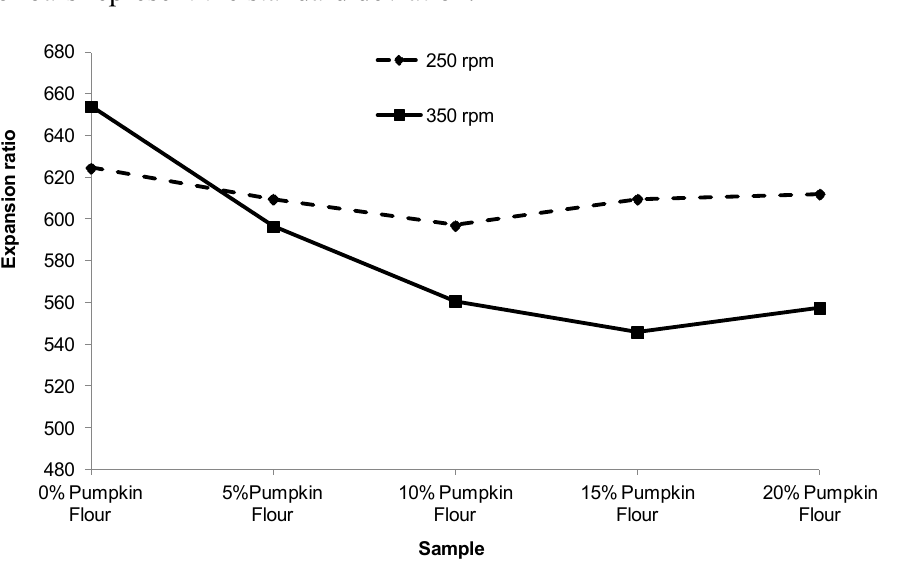
Figure 4. Effect of screw speed and the proportion of pumpkin flour on the expansion ratio. Error bars represent the standard